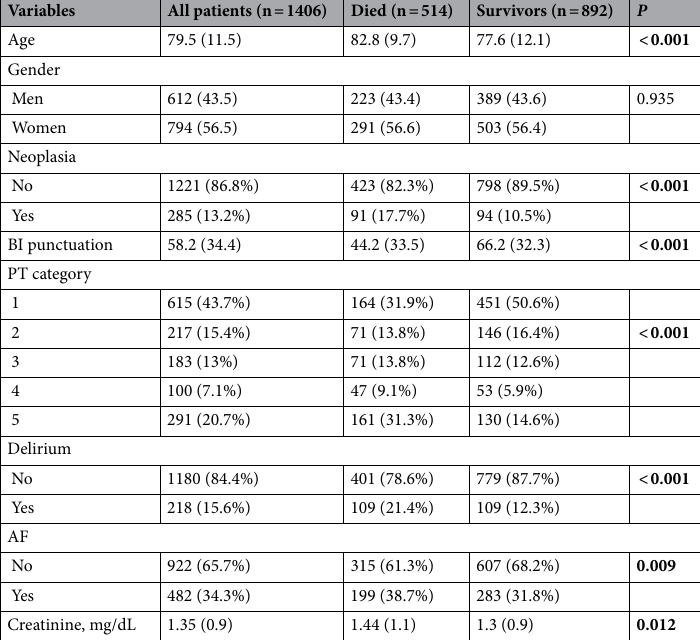
Table 2. Comparison between survivors and dead patients after one-year follow-up, in all patients included in the 4 groups. BI: Barthel index, PT: Pfeiffer´s test, AF: Atrial fibrillation. Significant values are in bold.